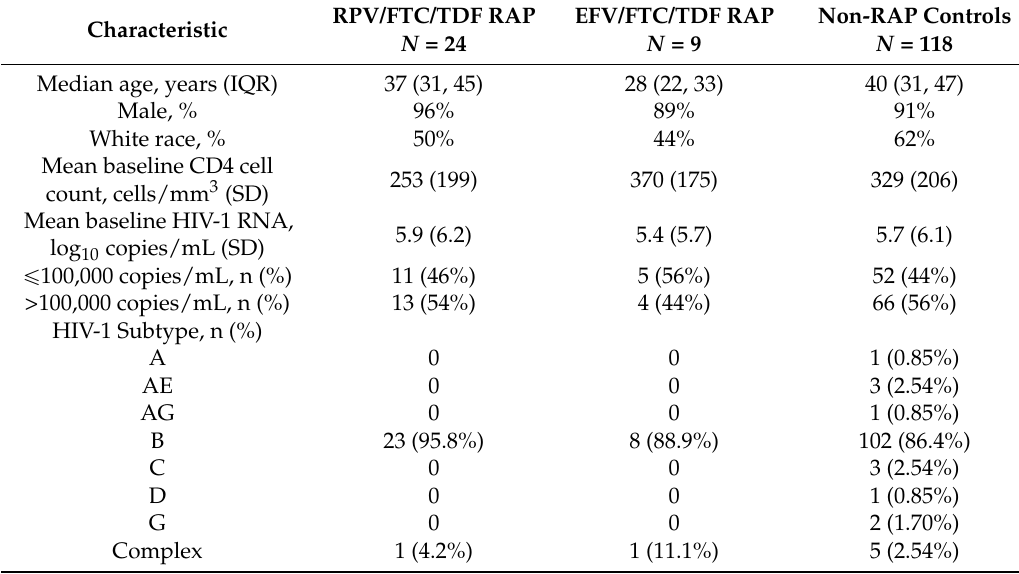
Table 1. Baseline characteristics of subjects included in deep sequencing analysis.